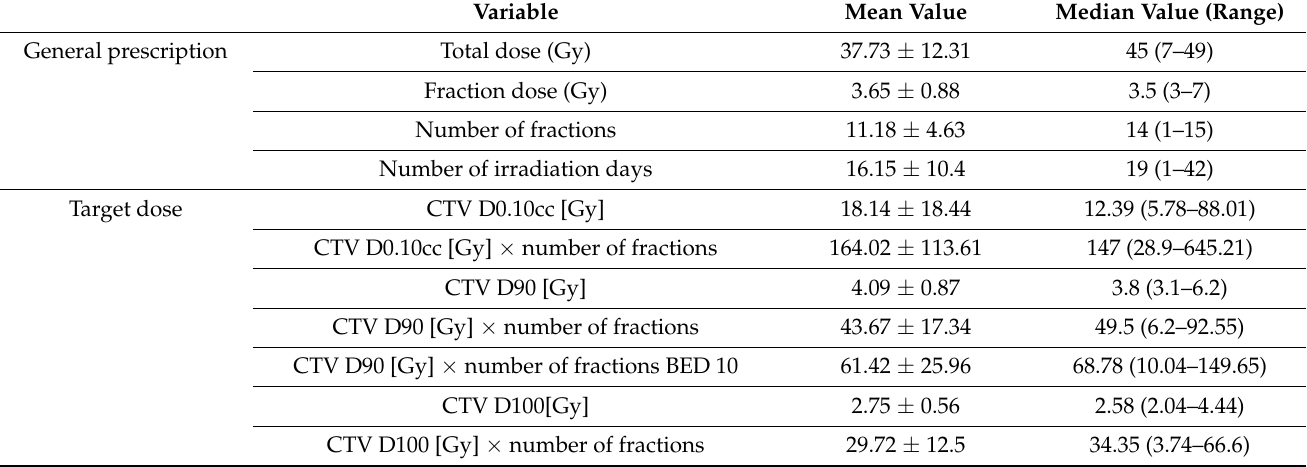
Table 3. Dosimetry characteristics of doses in particular target volumes and in the brain and associated bone. CTV—clinical target volume, V—volume, D—dose, BED—biologically effective